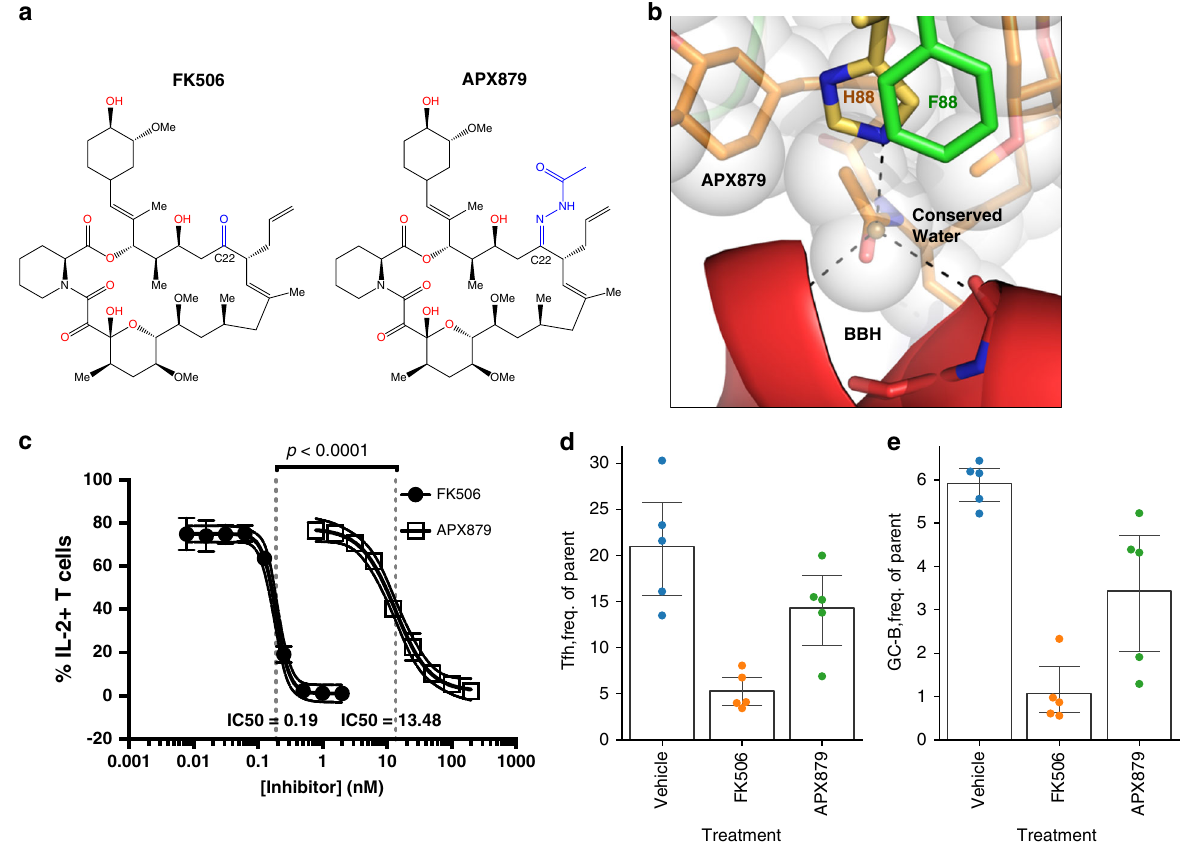
Fig. 6 The FK506 analog APX879 has reduced immunosuppressive activity. a Chemical structures of FK506 (left) and APX879 (right) with modi fi ed C22 indicated in blue. b Model of APX879 bound to A. fumigatus CN – FKBP12 complex. APX879 was overlaid on FK506 in the A. fumigatus crystal structure and steric clashes with the acetohydrazine substitution were minimized manually. The oxygen atom donated by the substitution was placed such that it occupies a similar space to the conserved water bound to the BBH. c Naive primary murine CD4 + T cells (from C57BL/6 mice) activated and differentiated in vitro and treated with FK506 have a reduced fraction of IL-2-producing cells than those treated with APX879. Dose response curves demonstrate an over 70-fold decrease in IL-2 production for FK506 compared to APX879. Note that the plot is showing a 95% con fi dence interval for the four-parameter curve fi t, error bars for individual points represent the standard error value. The IC50 range is 0.17 – 0.21 for FK506 and 10.7 – 16.9 for APX879. d , e T helper cells ( d ) and germinal center (GC) B cells ( e ) collected from lymph nodes of mice treated for 8 days with vehicle, 5 mg/kg FK506, or 20 mg/kg APX879. Lymph nodes were collected 7 days following immunization with NP-OVA to stimulate T cell-dependent GC-B cell response. Error bars indicate boot strapped 95% con fi dence intervals. See also Supplementary Fig.